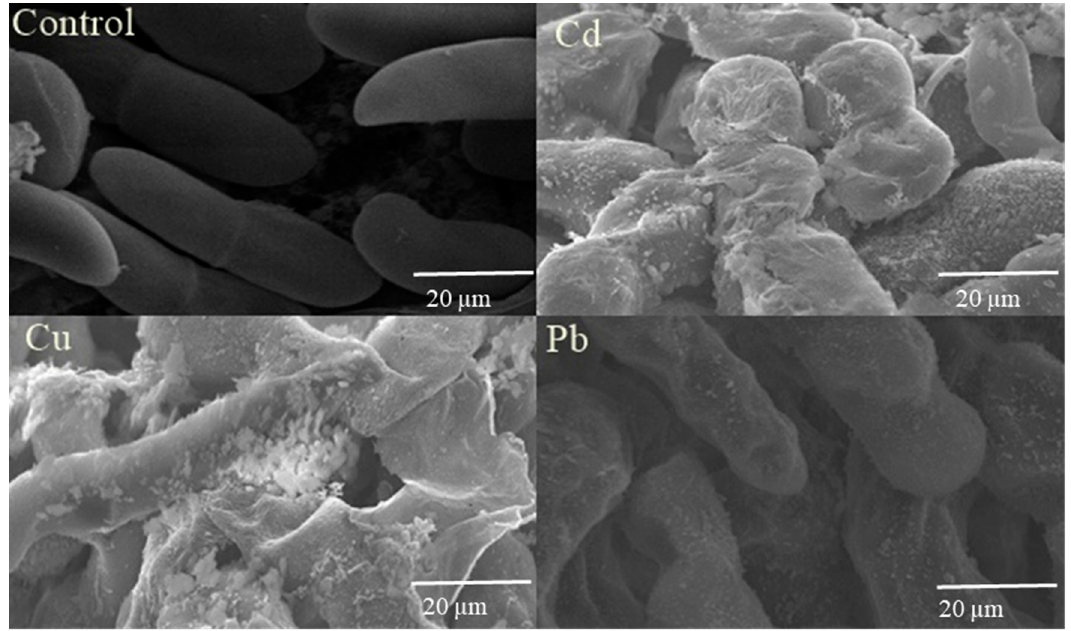
Figure 5. Scanning electron microscopy (SEM) photomicrographs of K. phaffi (WS), grown with no metal (control), with 4000 ppm cadmium (Cd), with 4000 ppm chromium (Cr) and with 4000 ppm lead (Pb).